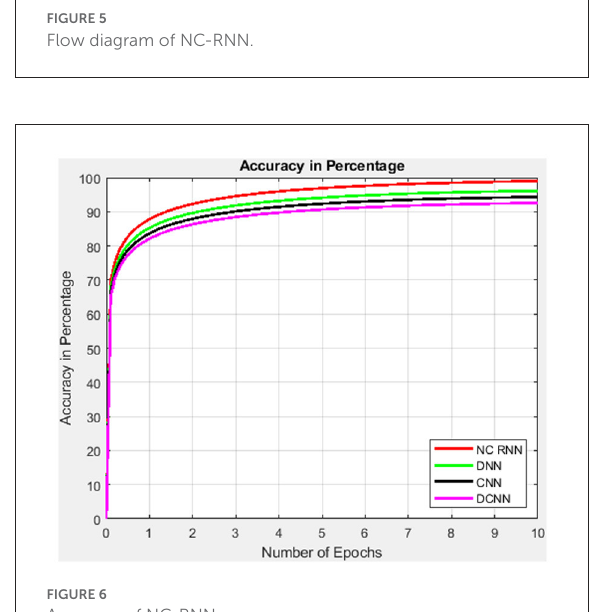
FIGURE7 Sensitivity of NC-RNN.